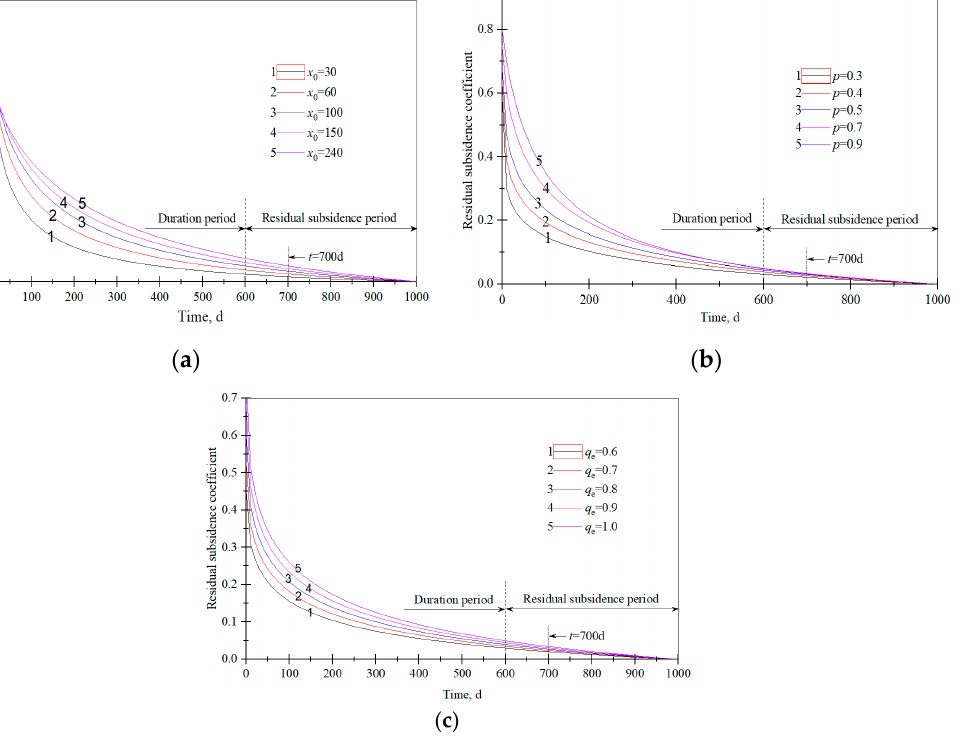
Figure 13. Diagrams of the influence of model parameters on residual subsidence coefficient over time: ( a ) the influence of model parameters x 0 on residual subsidence coefficient; ( b ) the influence of model parameters p on residual subsidence coefficient; ( c ) the influence of model parameters q e on residual subsidence coefficient.